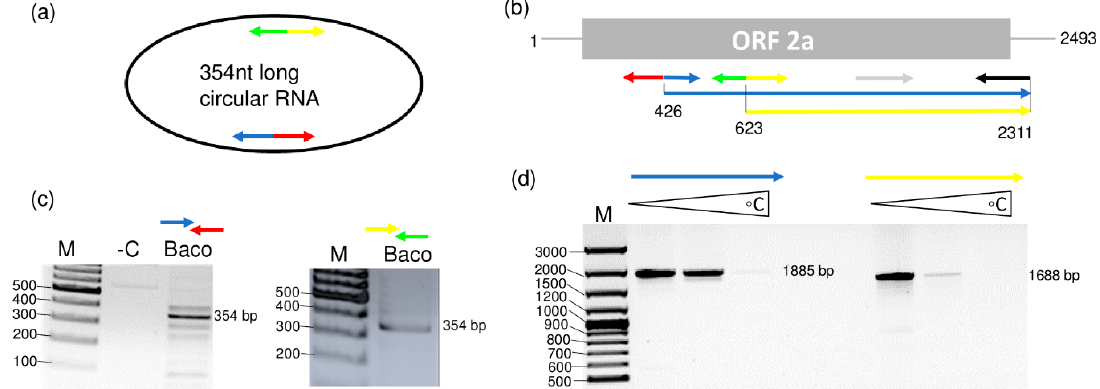
Figure 5 . Validation of the circular RNA presence in the GLPV-infected grapevine. Strategies used to amplify the complete sequence of the ( a ) circular RNA (derived from RNA2) and ( b ) of the partial sequence of RNA2 of GLPV, using sense and antisense primers, both designed on sequences of RNA2, indicated by multi-coloured arrows. RT-PCR amplifications using ( c ) circular RNA-derivate and ( d ) RNA2-specific primers. M: GeneRuler 100 bp Plus DNA ladder (Thermo Fisher Scientific). Triangles show RT-PCR amplicons produced at different annealing temperatures (50–56–64 °C).